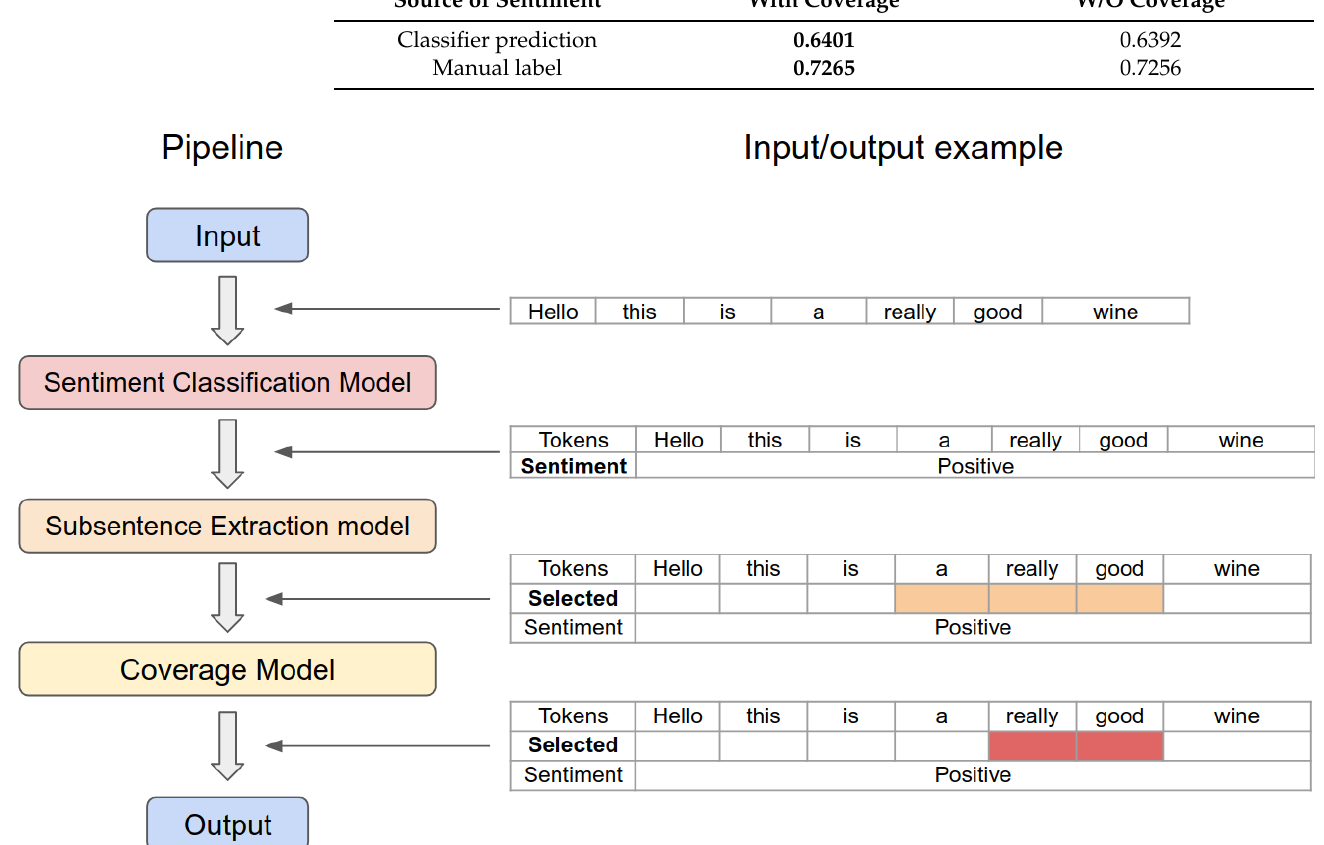
Figure 15. Sentiment and subsentence prediction pipeline. This diagram is manually illustrated with an example just to highlight refining procedure with the proposed coverage